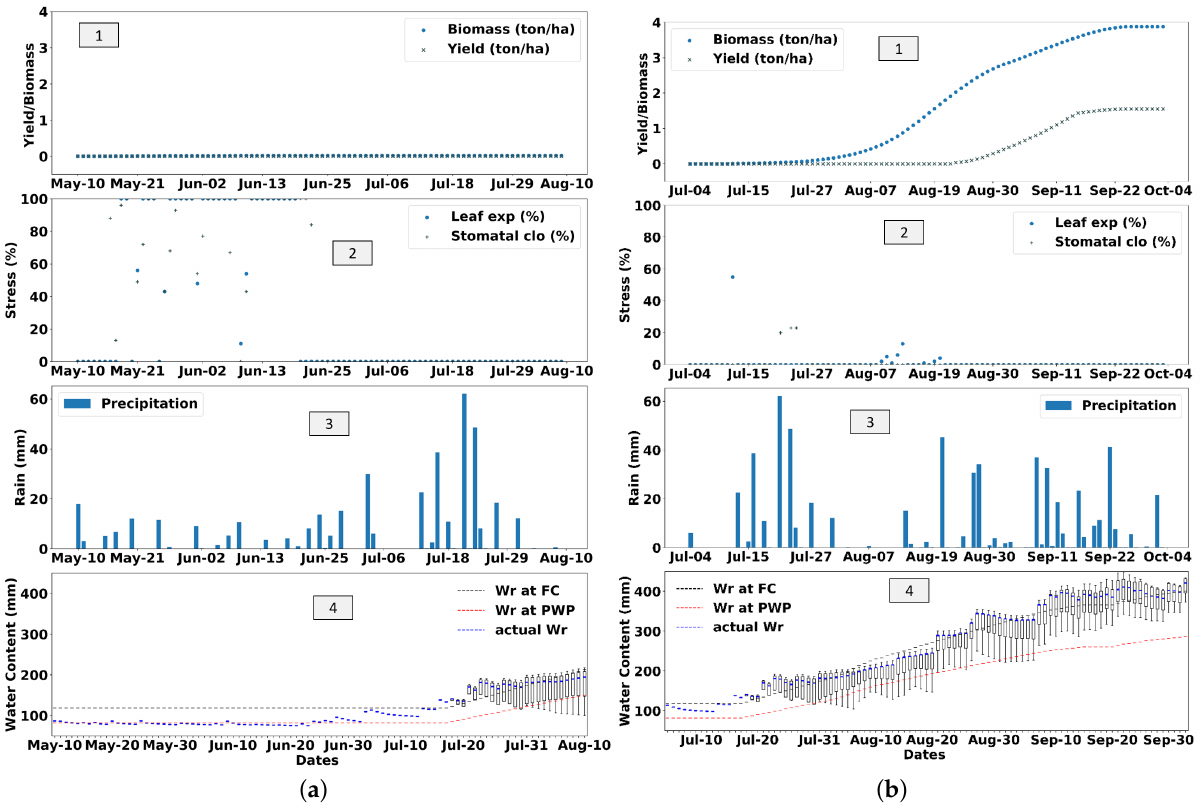
Figure 7. Crop yield and biomass accumulation (1), stress effects on leaf and stomatal closure (2), daily rainfall (3), and water content in the effective rooting zone (4)) for sowing dates according to LO20mm on 10 May 2020 ( a ), and a date within safe sowing window (4 July 2020)—Gaoua ( b ). Actual Wr is the water content in the effective root zone compared to water content at field capacity (FC) and at permanent wilting point